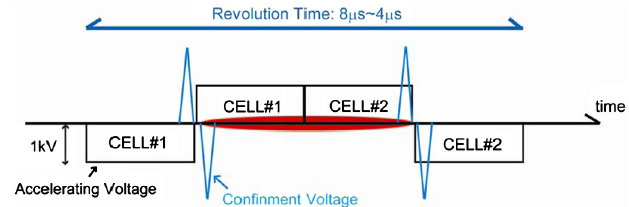
FIG. 31. First stage of acceleration ( 2 (cid:1) s < T r < 13 : 6 (cid:1) s ). To generate a long accelerating voltage, two type B ICs are trig- gered in series. Pulse shapes shown by the sky blue lines represent the voltage pulses for confinement in the longitudinal direction.